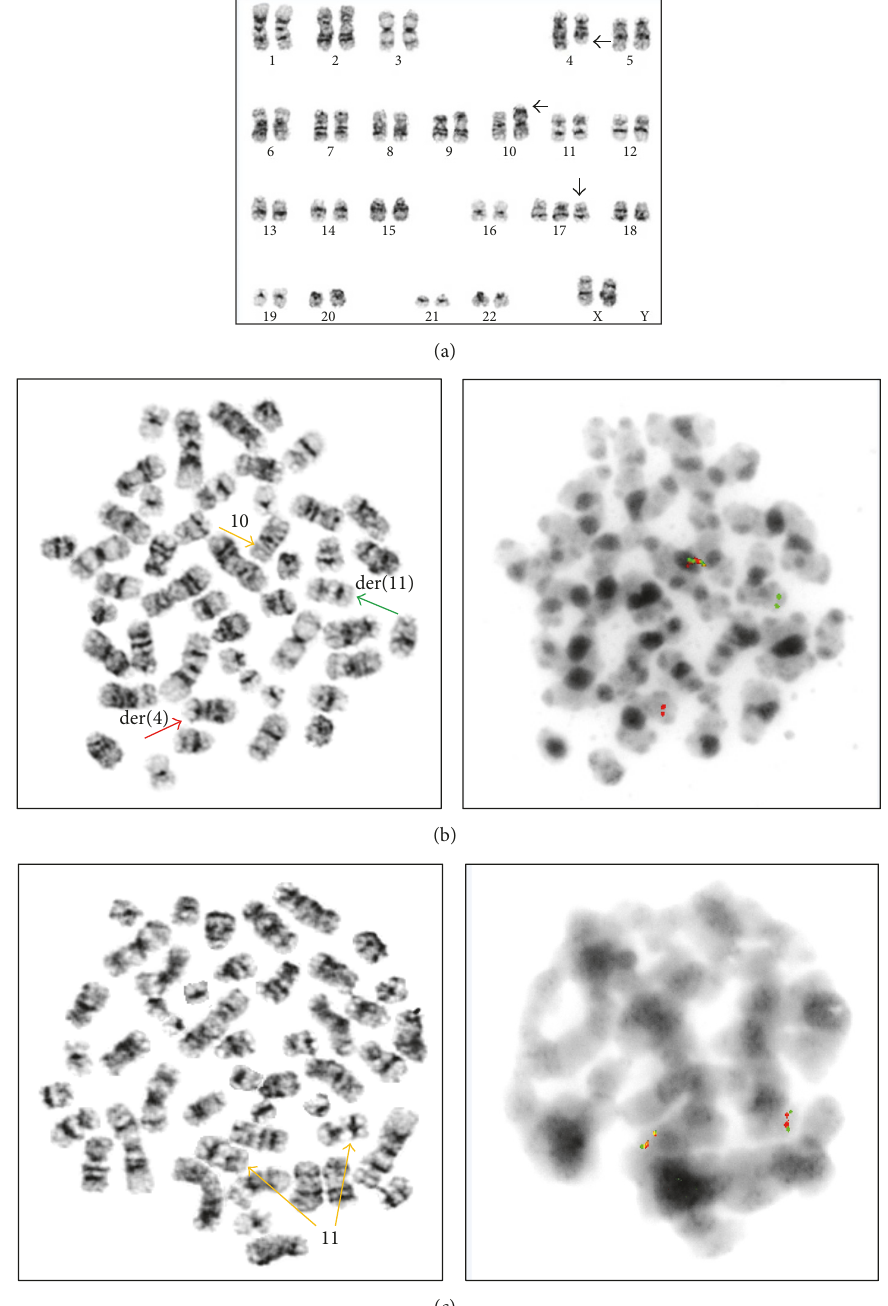
Figure 3: Cytogenetic and FISH results from patient #1. (a) Conventional karyotype with 47, XX, 𝑡 (4;10)(q28;p12), +17. (b) Break-apart AF-10 probe on sequential G-banded to FISH metaphases shows that telomeric 3 󸀠 AF10 moves to the 4q28, and the centromeric 5 󸀠 AF10 signal inserts into the 11q23 region. (c) The MLL FISH is not rearranged. In (a), the arrows to 4p28 and 10p12 are for indication of 𝑡 (4;10)(q28;p12); the arrow to chromosome 17 is for indication of